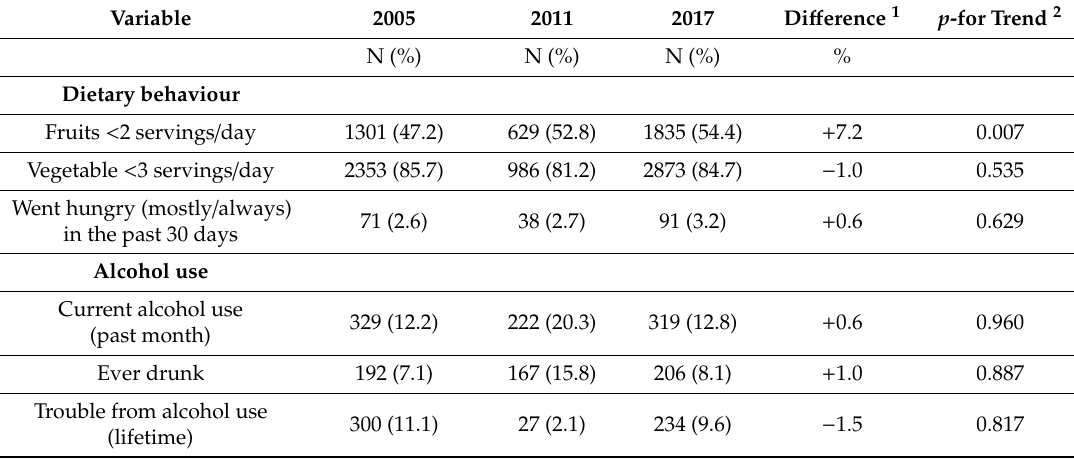
Table 4. Health risk behaviours in 2005, 2011 and 2017 among female in-school adolescents in